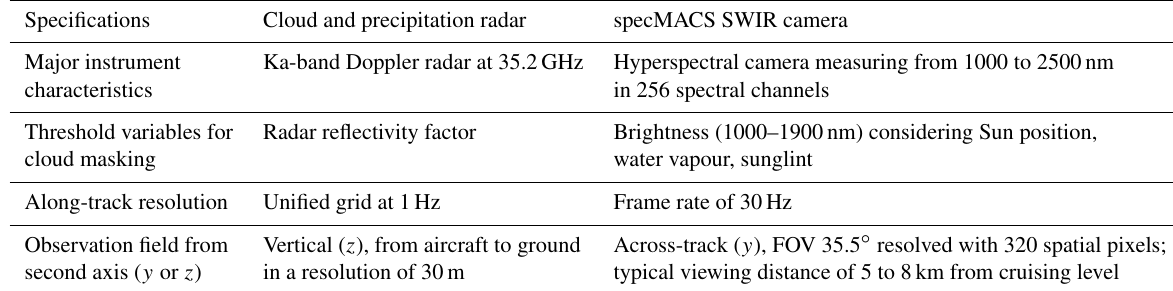
Table 1. Cloud mask specifications from radar and imager specMACS (SWIR